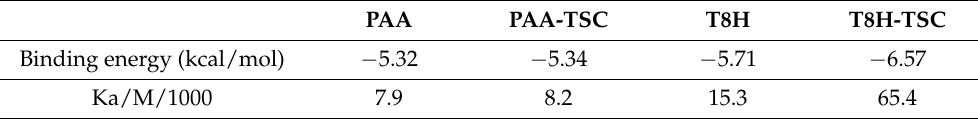
Figure 11. Complex of PLpro with T8H (tryptanthrin). The upper panel shows a 3D model of PLpro with a binding site (cavity) on its surface for tryptanthrin. The lower panel shows the binding mode of T8H-TSC with the amino acid residues of PLpro. Figure 11 was created with UCSF Chimera ( upper panel ) and BIOVIA Discovery Studio Visualiser ( lower panel ) and shows the best docking pose of tryptanthrin on PLpro. We can also see where tryptanthrin is placed on the PLpro’s surface and the general view of the PLpro (green–cyan–brown) complex with tryptanthrin (pink). The secondary structure of the protease behind the molecular surface (created with 90% transparency for better presentation of the molecule) is also shown. Table 3. Binding energy and association constant of PAA, PAA and T8H and T8H-TSC for